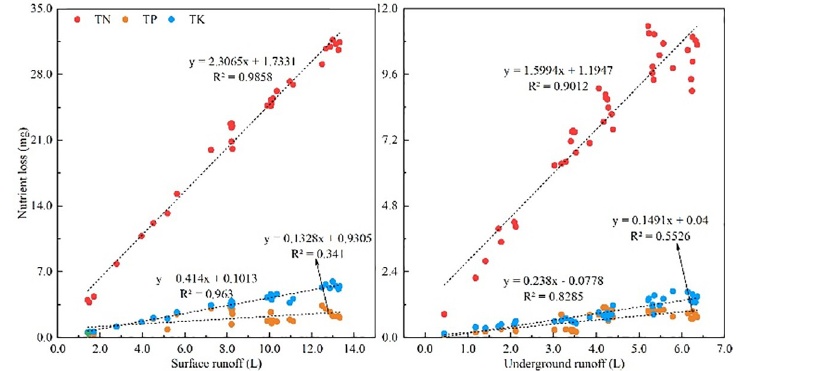
Fig 9. Fitting between nutrient loss and